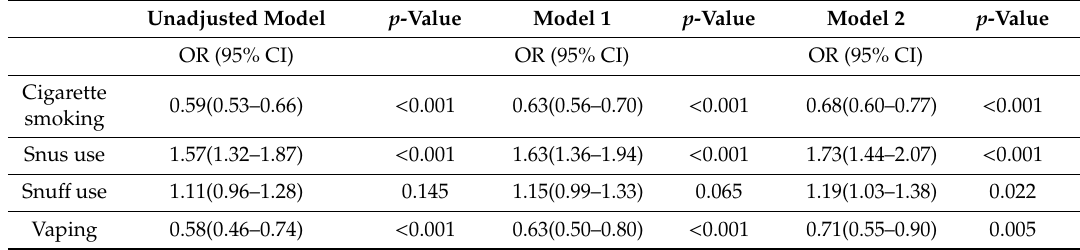
Table 2. Association between tobacco or nicotine use and sport (vs no